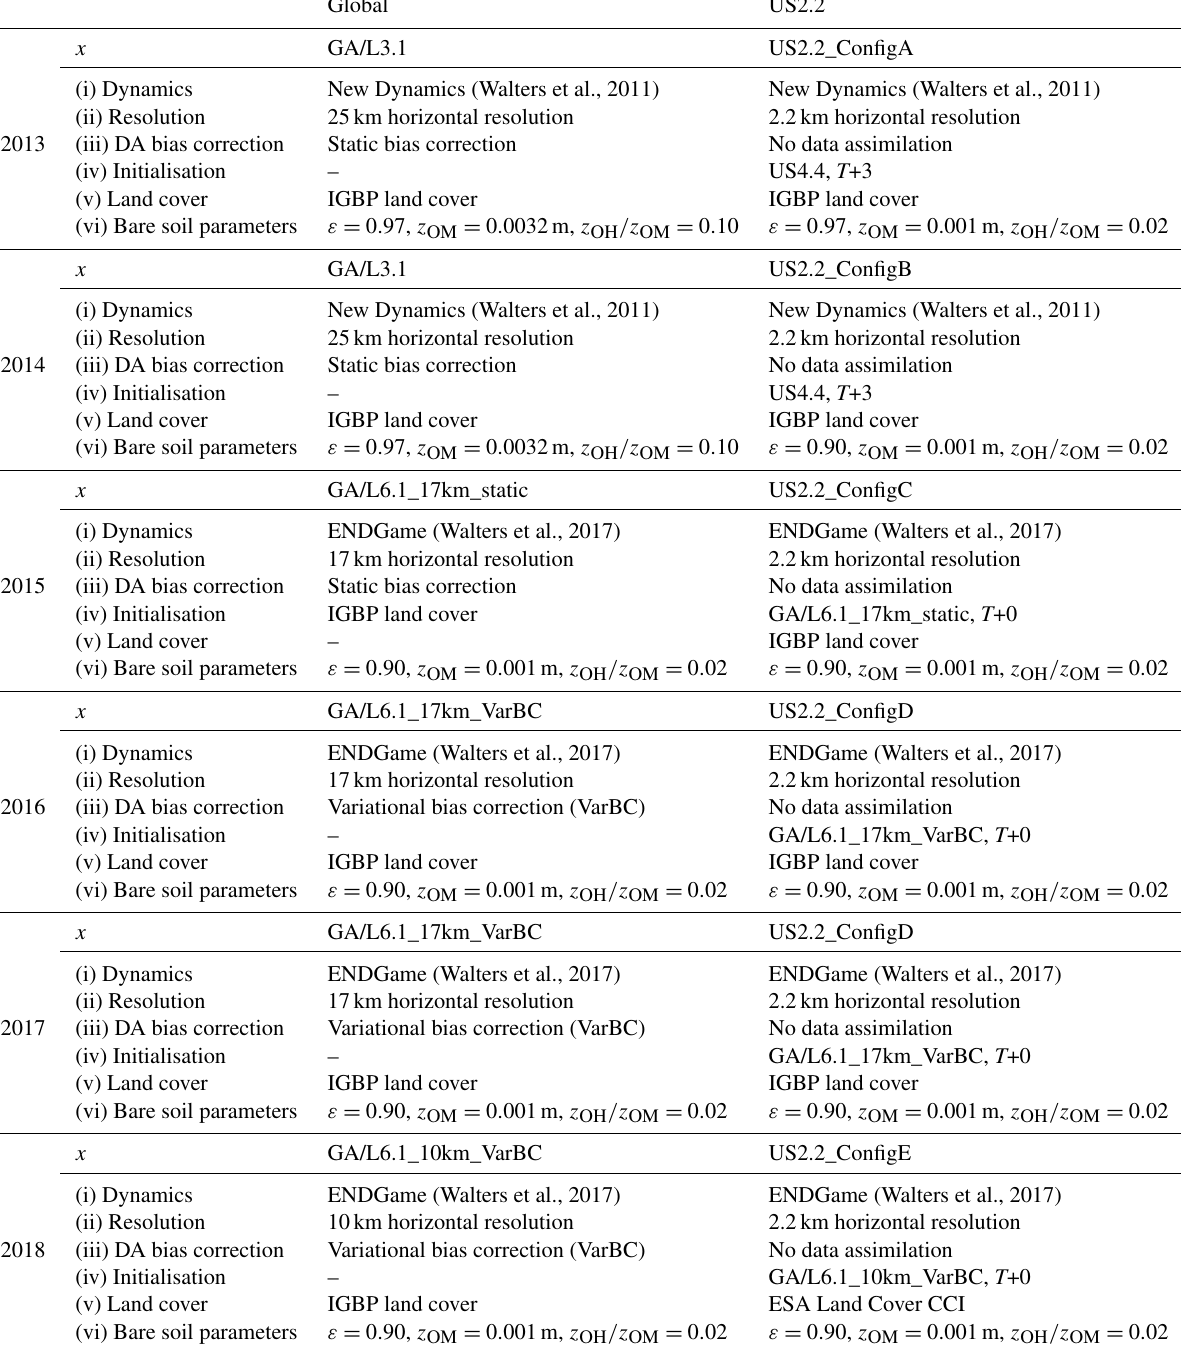
Table 1. Summary of UM configurations from 2013 to 2018. The ratio of the thermal to the momentum roughness lengths is abbreviated to z OH /z OM , z OM is the roughness length of momentum and ε is the bare soil